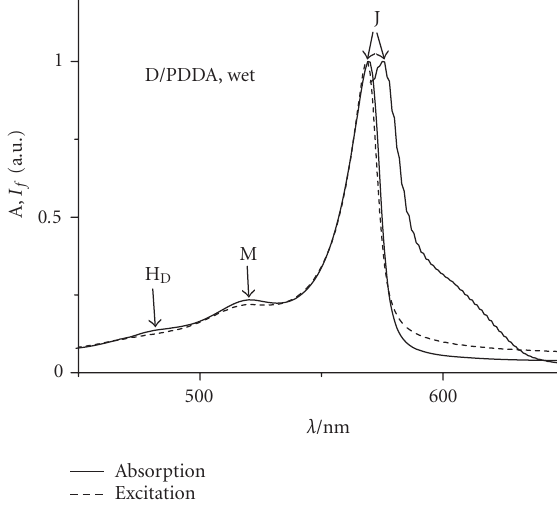
Figure 4: Absorption (solid), excitation (dashed), and emission spectra of a wet D/PDDA ESAM; 1 bilayer per side of the quartz plate; λ exc = 565nm, λ em =